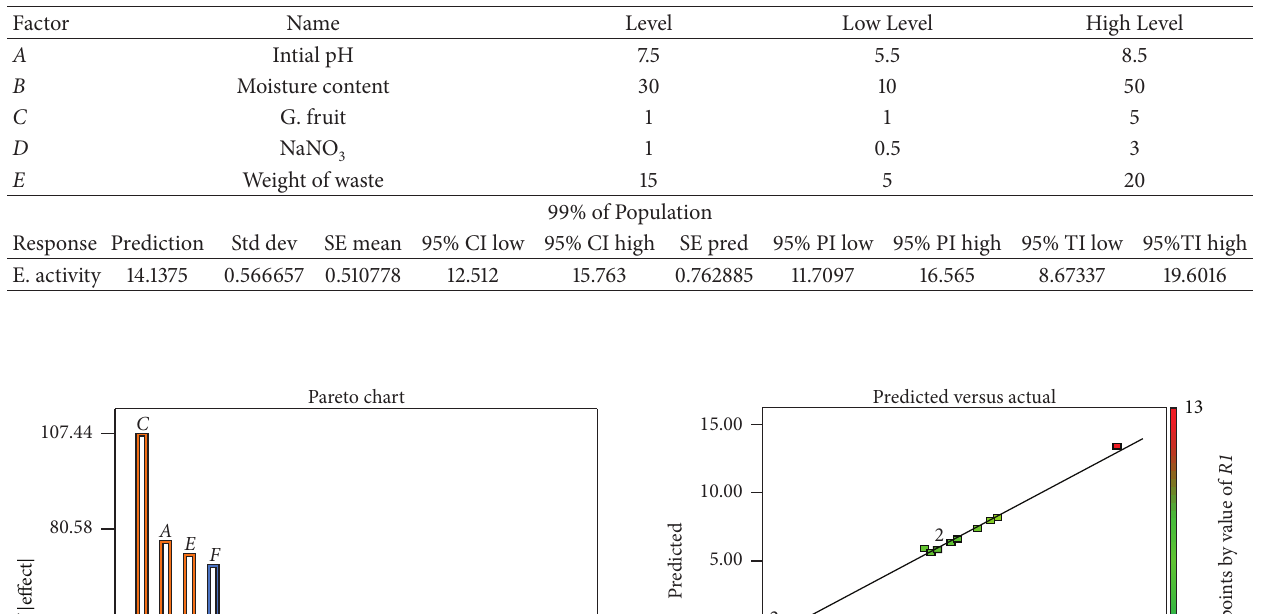
Table 7: Optimum conditions suggested by statistical calculations after performing the tests.